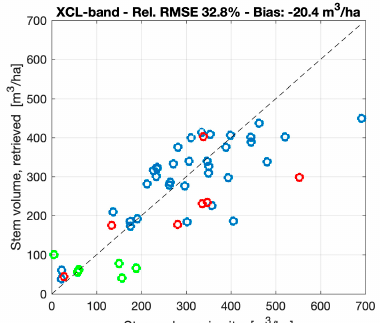
Figure 10. Scatter plot of measured and retrieved stem volume at Remningstorp for a combination of all estimates obtained at X-, C-, and L-band. Blue, red, and green circles refer to inventory plots with at least 50% spruce, pine, or birch trees, respectively.